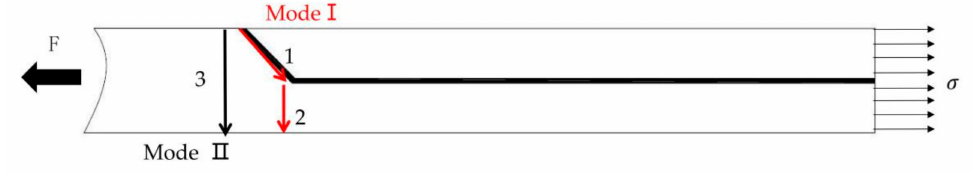
Figure 9. Two fracture modes of lap